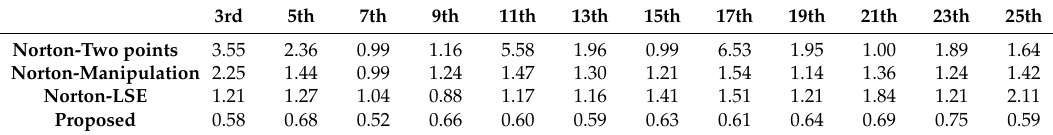
Table 7. Comparisons between the proposed method and Norton-based methods w.r.t. MAE.